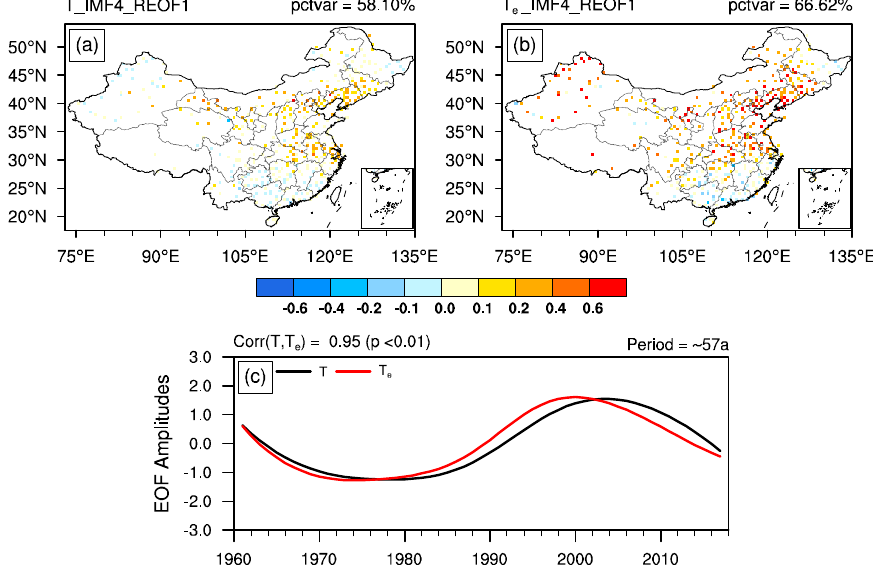
Figure 5. The first REOF modes of the IMF 4 of summertime T ( a ) and T e ( b ) in China, and the corresponding principal component ( c ). Note that the “pctvar” in the figure means percent variance; “Corr” means correlation coefficient between T and T e ; Black (Red) line represents the principal component of T ( T e ).